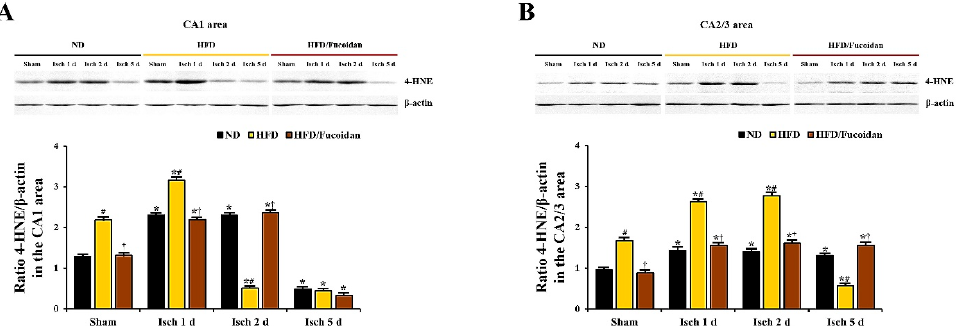
Figure 7. Western blot analysis of 4-HNE in the CA1 ( A ) and CA2/3 ( B ) areas ( n = 6/group). Protein expression is normalized to β -actin. The bars indicate the means ± SEM. * P < 0.05 vs. each sham group, # P < 0.05 vs. ND-fed group, † P < 0.05 vs. HFD-fed group.